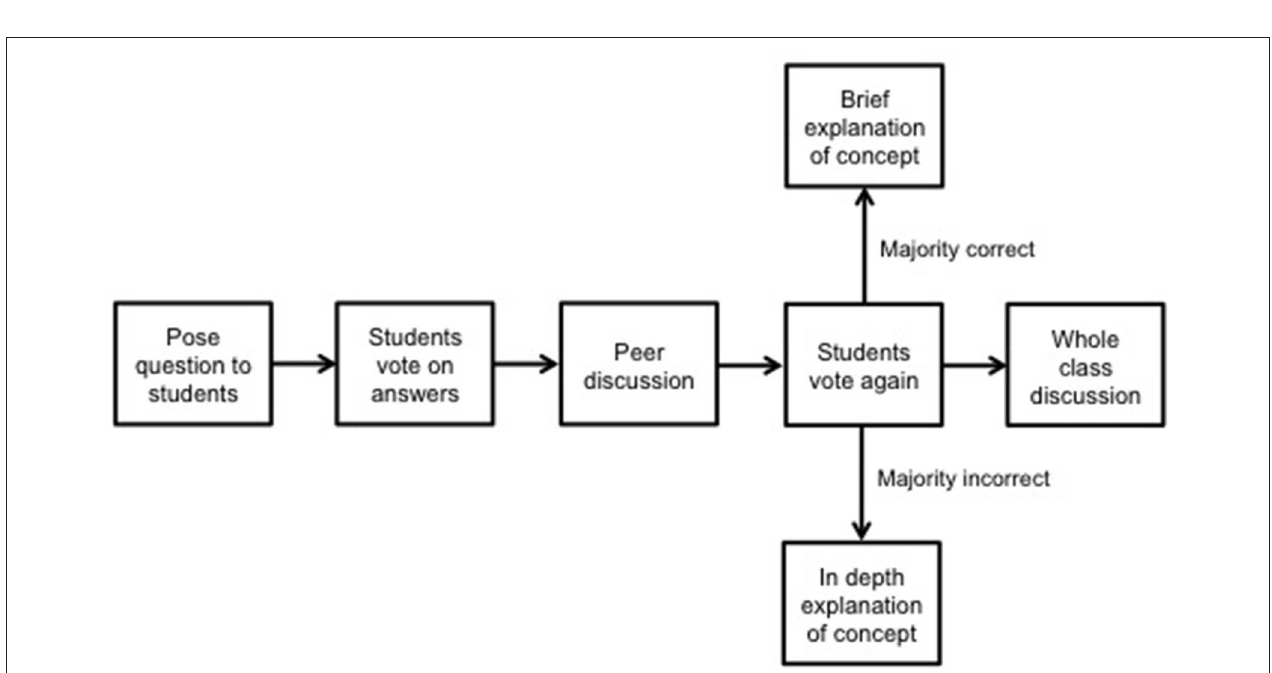
FIGURE 4 | Sequence of events involved in peer